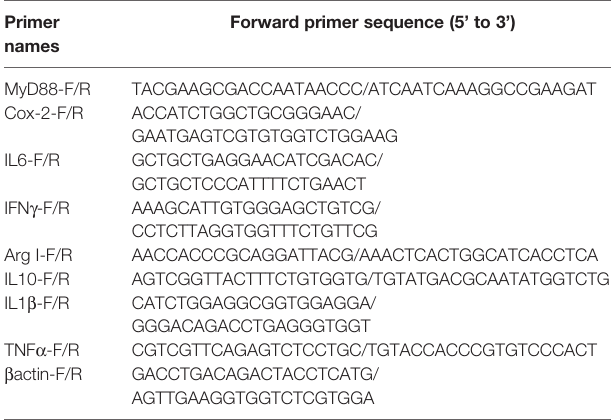
TABLE 1 | Primers used in the present study.